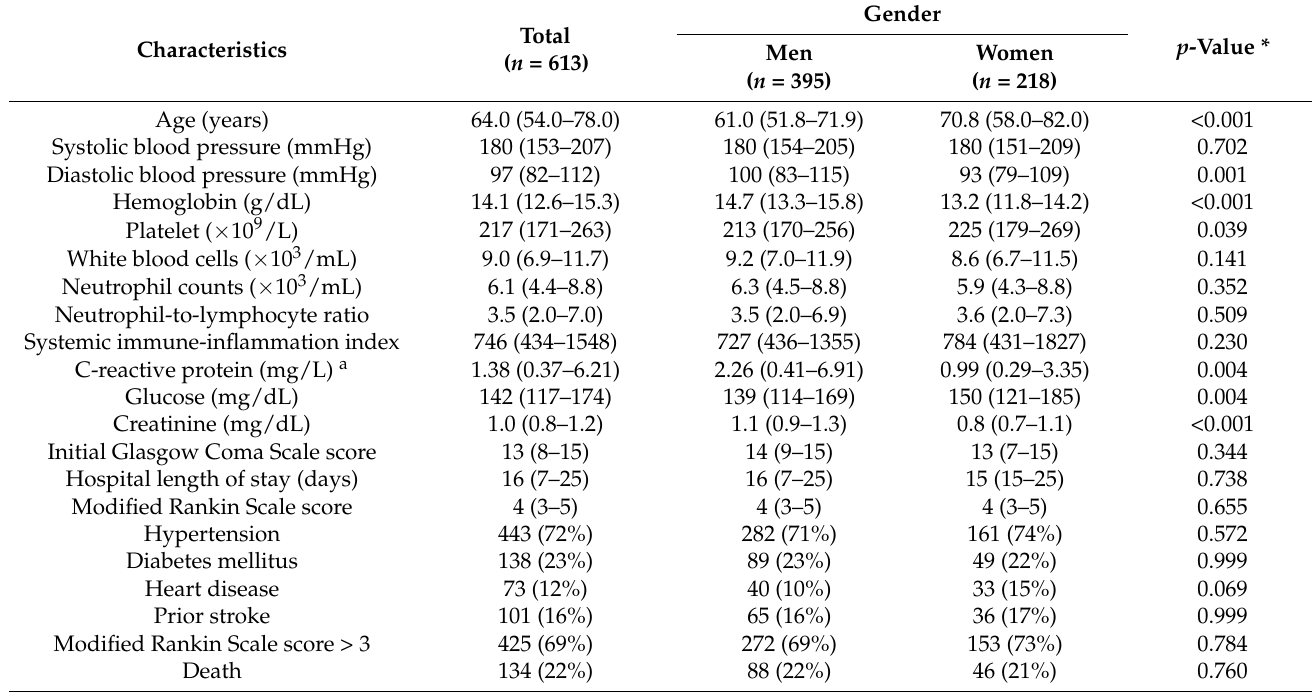
Table 1. Baseline data of clinical features of 613 patients with acute intracerebral